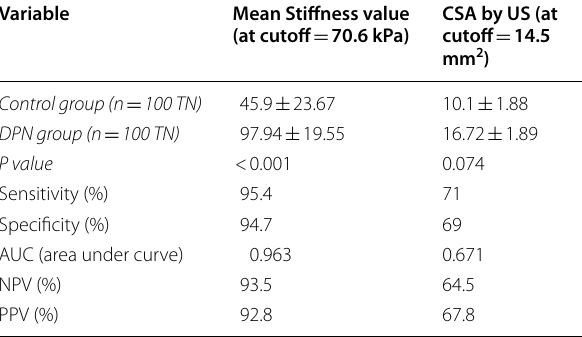
CSA cross sectional area, DPN Diabetic peripheral neuropathy, kPa kilopascals, − NPV Negative predictive value, PPV positive predictive value, TN Tibial nerve